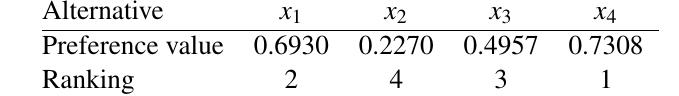
Table 7: The preference value of each alternative in the final decision